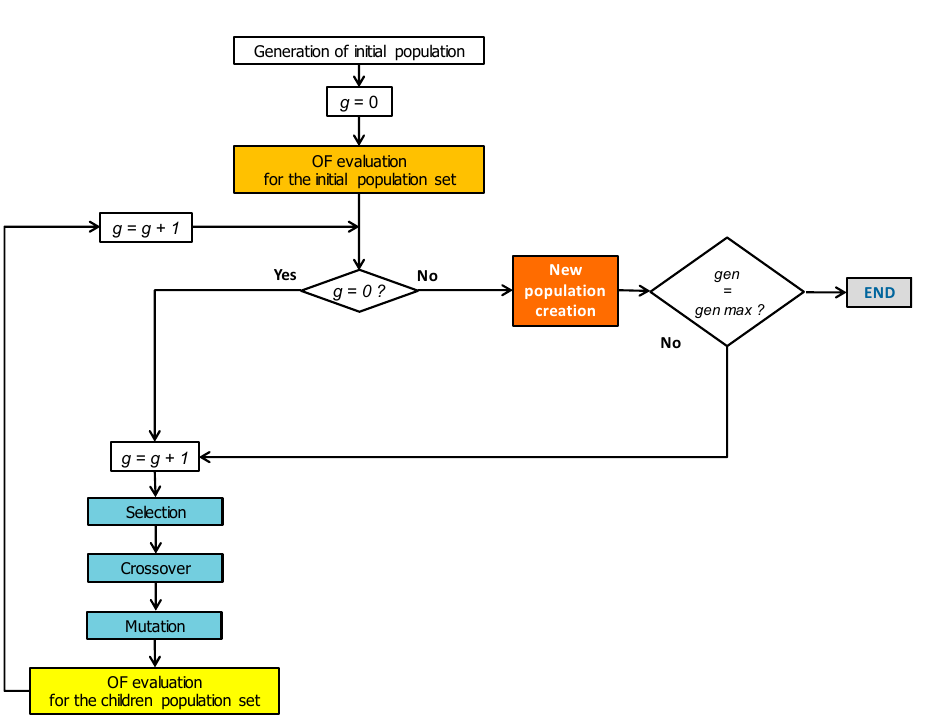
Figure 1. Genetic algorithm flow